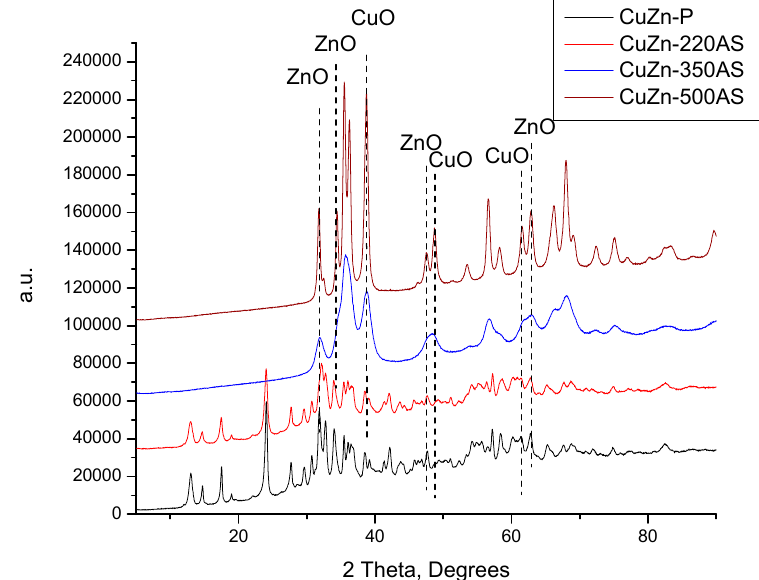
Figure 1. The XRD patterns of the catalysts prepared by the treatment of the CuZn precursor in static air at 220, 350, and 500 °C.